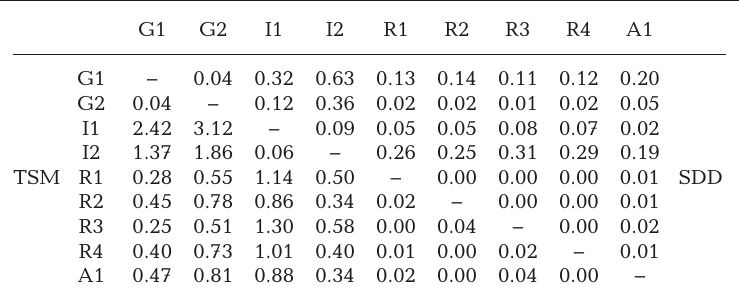
Table 3. One-way ANOVA analysis of total suspended matter (TSM, below the diagonal) and Secchi disk depth (SDD, above the diagonal) between Ildırı Bay